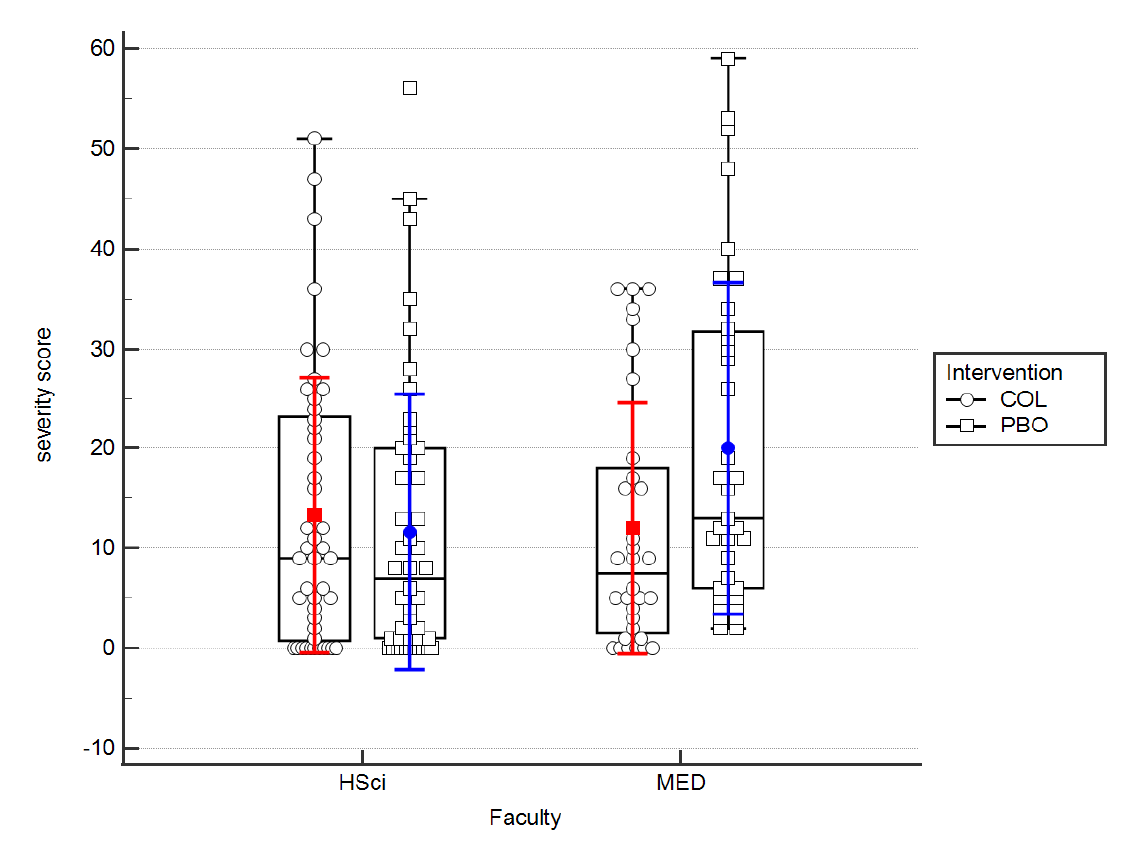
Figure 3. A bar plot on the efficacy of COL in reducing of the URTIs severity by the course of studies. Medians and IQRs are shown. Dots and squares depict individual cases. MED—medicine; HSci—health Science.